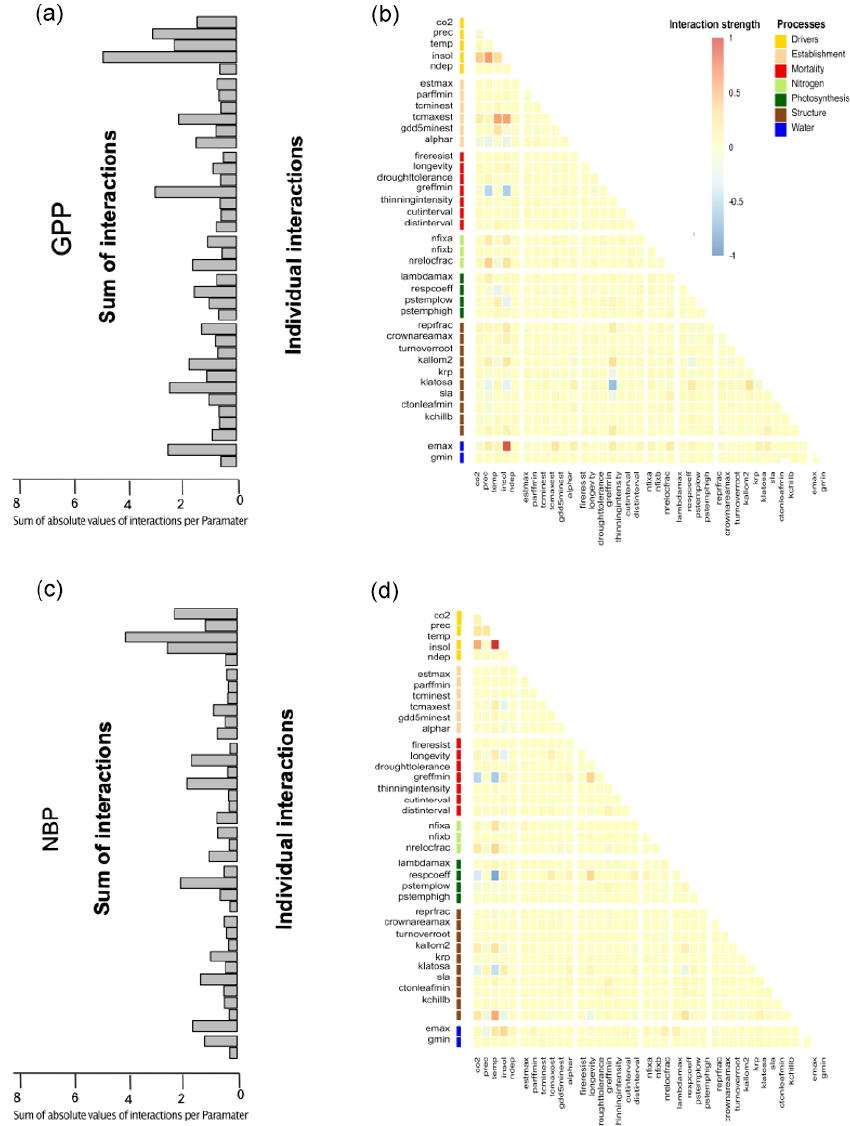
Figure A4. Interactions of uncertainty contributions of GPP and total standing biomass are similar to net biome productivity, with most interactions arising from environmental